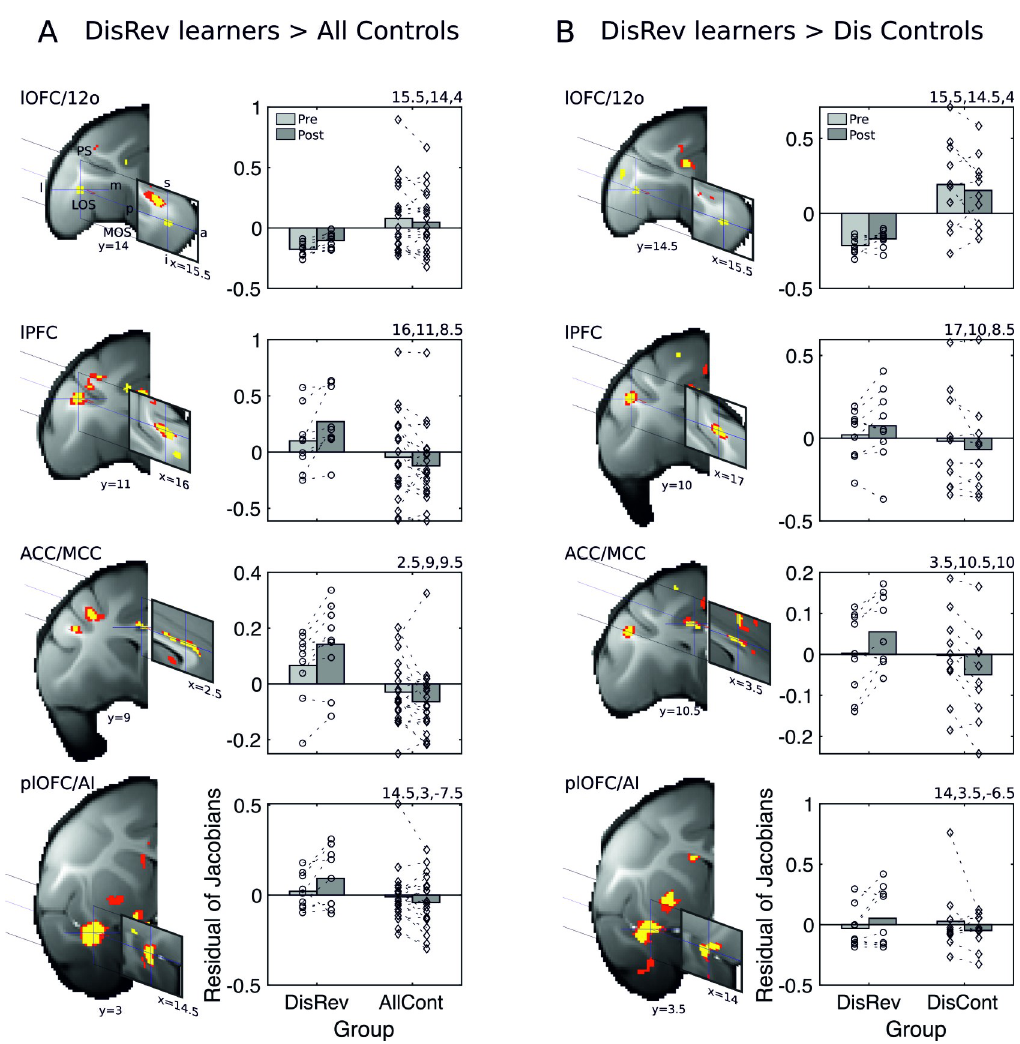
Fig 2. Learning DisRev was associated with distributed gray matter increments (A) relative to all control animals, including in the same set of brain regions as identified in experiment 2: lOFC/12o (cross hairs in top row), ventral bank of the PS in anterior lPFC (cross hairs in second row), ACC/MCC (cross hairs in third row), and plOFC/AI (cross hairs in bottom row). Panel B illustrates that excluding NoDis Controls from the analysis revealed the same set of brain regions with increases in gray matter in lOFC/12o, ventral bank of the PS, ACC/MCC, and plOFC/AI. Results of analysis testing for bilaterally symmetrical effects ( p < 0.001) are shown in yellow and red ( p < 0.005). Across analyses, gray matter shows relative increases after learning in the DisRev animals and relative decreases in the NoDis Controls or Dis Controls. Because in the initial stages of analysis, all scans from both before and after training are registered to a template derived from their group average, the baseline residual Jacobian values in each figure lie close to the mean. 12o, orbital part of area 12; a, anterior; ACC/MCC, anterior cingulate cortex/ midcingulate cortex; AI, anterior insula; AllCont, all control; Dis Control, discrimination control; DisRev, discrimination reversal; I, inferior; l, lateral; lOFC, lateral OFC; lPFC, lateral prefrontal cortex; m, medial; LOS, lateral orbital sulcus; MOS, medial orbital sulcus; NoDis Control, no-discrimination control; OFC, orbitofrontal cortex; p, posterior; plOFC, posterior lOFC; plOFC/AI, plOFC extending into AI; PS, principal sulcus; s, superior. Data are available on https://www.jeromesallet.org/ data-ofc-reversal-learning and https://doi.org/10.5281/zenodo.3776631. (two levels: left and right) × structural scan (two levels) × group (two levels: Dis Controls, NoDis Controls). This analysis failed to identify an interaction between session and group (F = 0.169, p = 0.686) or any other subsidiary interactions including session and group (all 1,18 p ’s > 0.292).